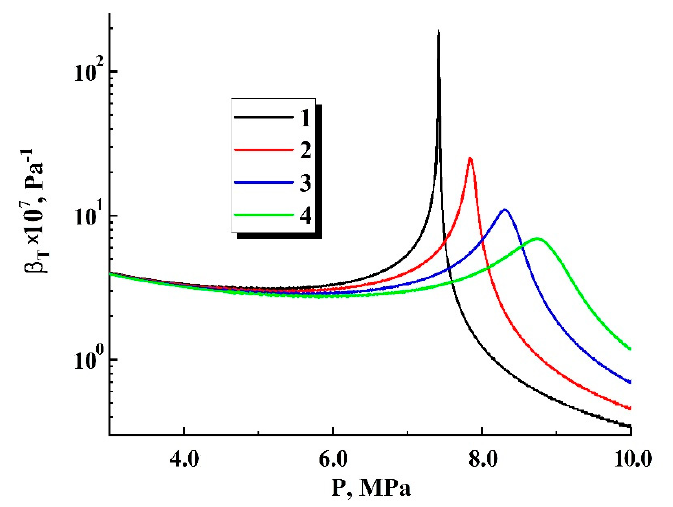
Figure 10. Dependencies of isothermal compressibility of carbon dioxide on the pressure (recovered using isothermal data published elsewhere [40]). 1— T = 304.4 K (near the critical temperature); 2— T = 307.0 K; 3— T = 310.0 K; 4— T = 313.0 K.